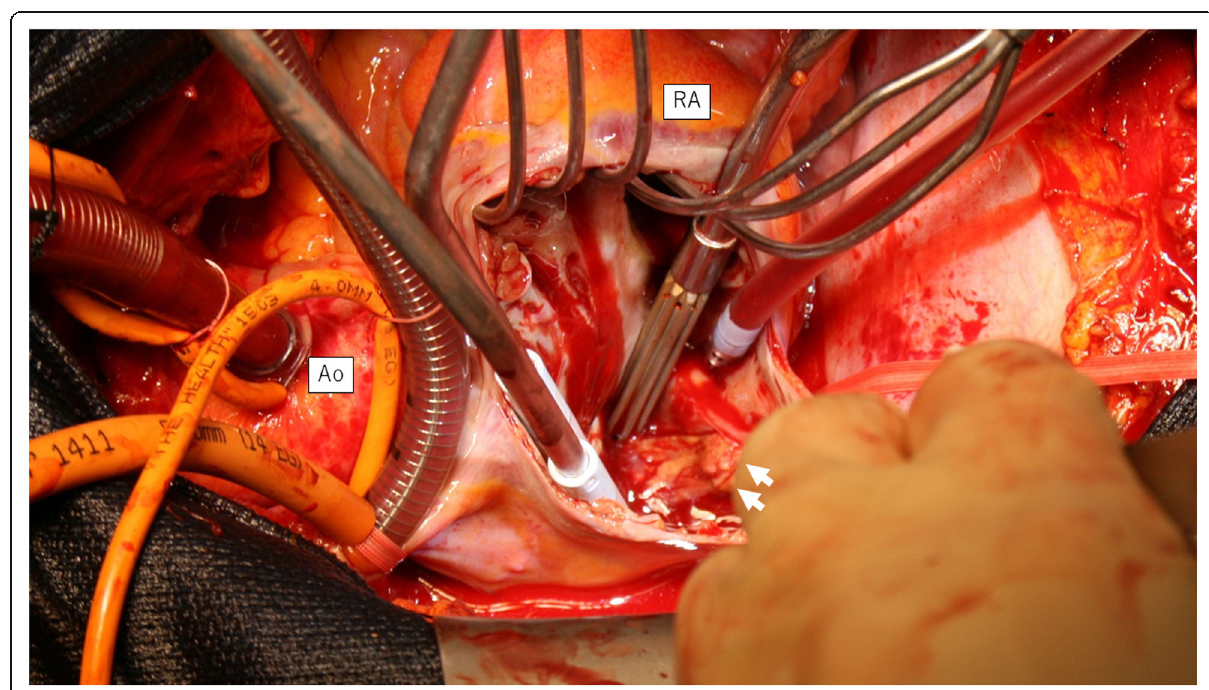
Fig. 6 Intraoperative findings: the yellow-brown tumor originated from the IVC and had a size of 3 × 1 cm (arrow). IVC inferior vena